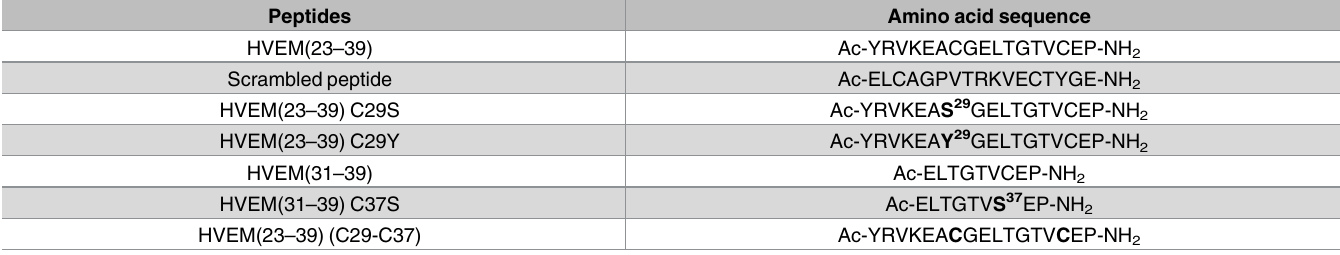
Table 2. Sequences of tested peptides.